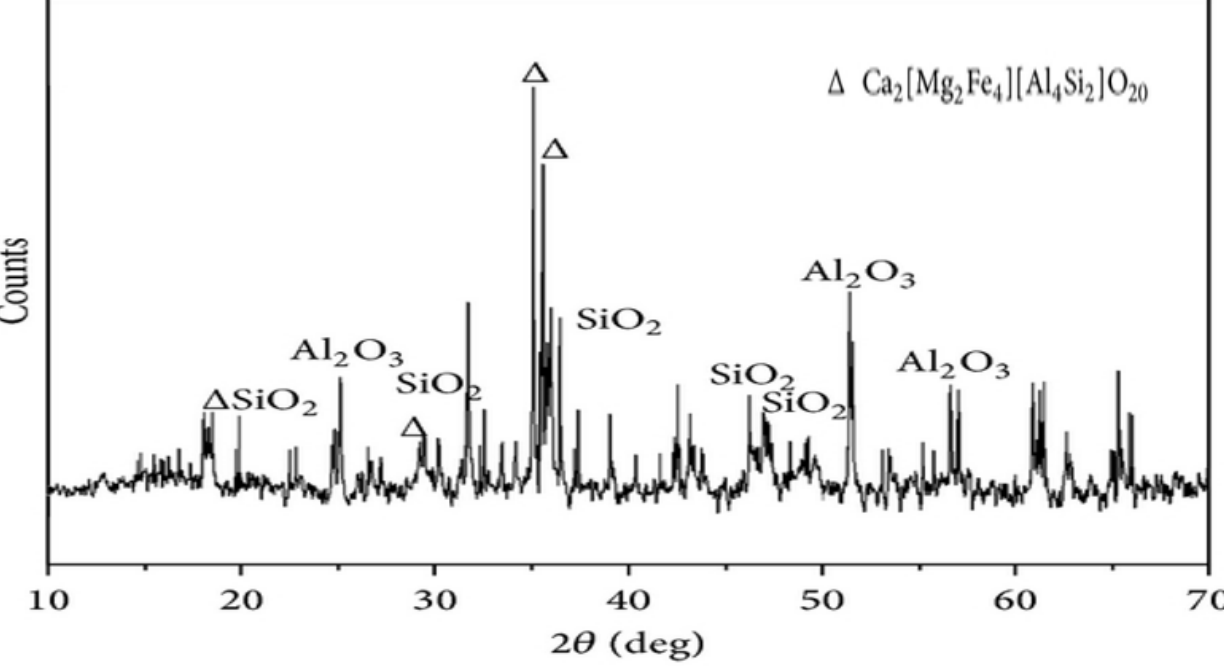
Figure 4. XRD test results of CPS [58]: Used as per Elsevier permission